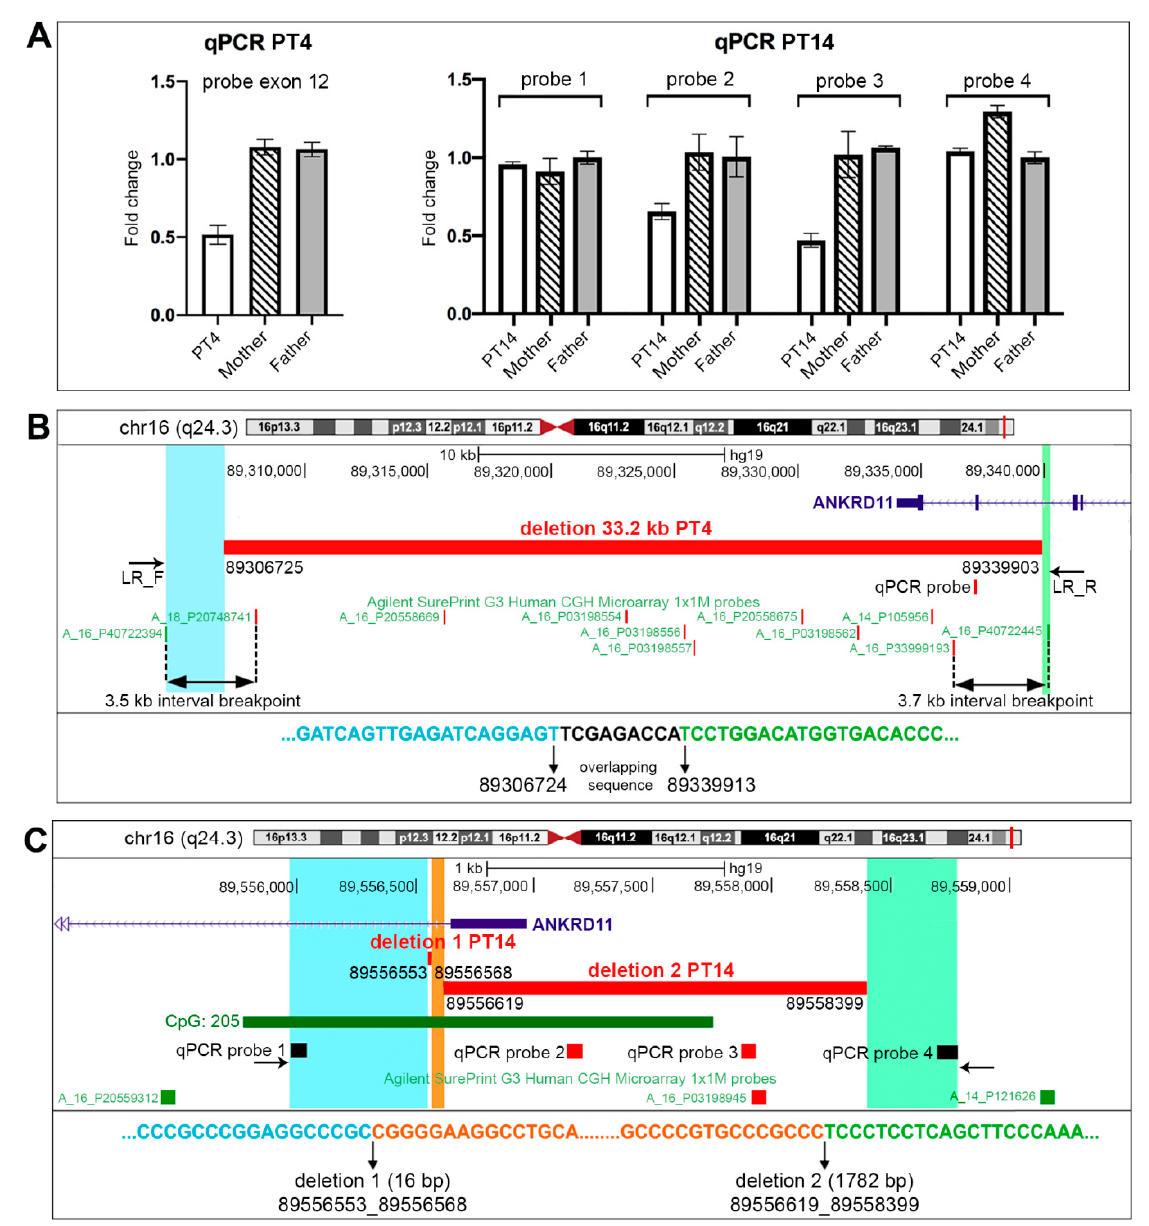
Figure 4. CNV characterization of PT4 and PT14. ( A ) Quantitative PCR on gDNA. qPCR results for PT4 and PT14, using probes spanning specific ANKRD11 genomic regions to characterize the CNVs. The mother and father of each patient were used as normal controls. ( B ) Physical map of PT4’s deletion. The specific deletion of 33.2 kb with the relative nucleotide position is shown as a horizontal red bar. The qPCR probe on exon 12 and the Long-Range primers LR_F and LR_R used to redefine the CNV at the nucleotide level are shown. Interval breakpoints (black double-end arrows) are delimited by the CMA probes, which are shown in green if not deleted, and in red if deleted. The sequenced regions are highlighted in light blue and light green, with the breakpoint corresponding to the nucleotide sequence depicted below; a micro-homology region is indicated in black characters. ( C ) Physical map of PT14’s deletions. The specific deletions with the corresponding nucleotide breakpoint positions are shown as red bars. The CMA probes are shown in green if not deleted, and in red if deleted. qPCR probes are depicted in black or in red if deleted. The sequenced regions using qPCR probe 1 forward and qPCR probe 4 reverse are highlighted in light blue, orange, and light green. The corresponding nucleotide sequence is depicted below, and the breakpoints leading to the formation of the two 16 bp and 1782 bp adjacent deletions involving the promoter region of ANKRD11 are indicated by the